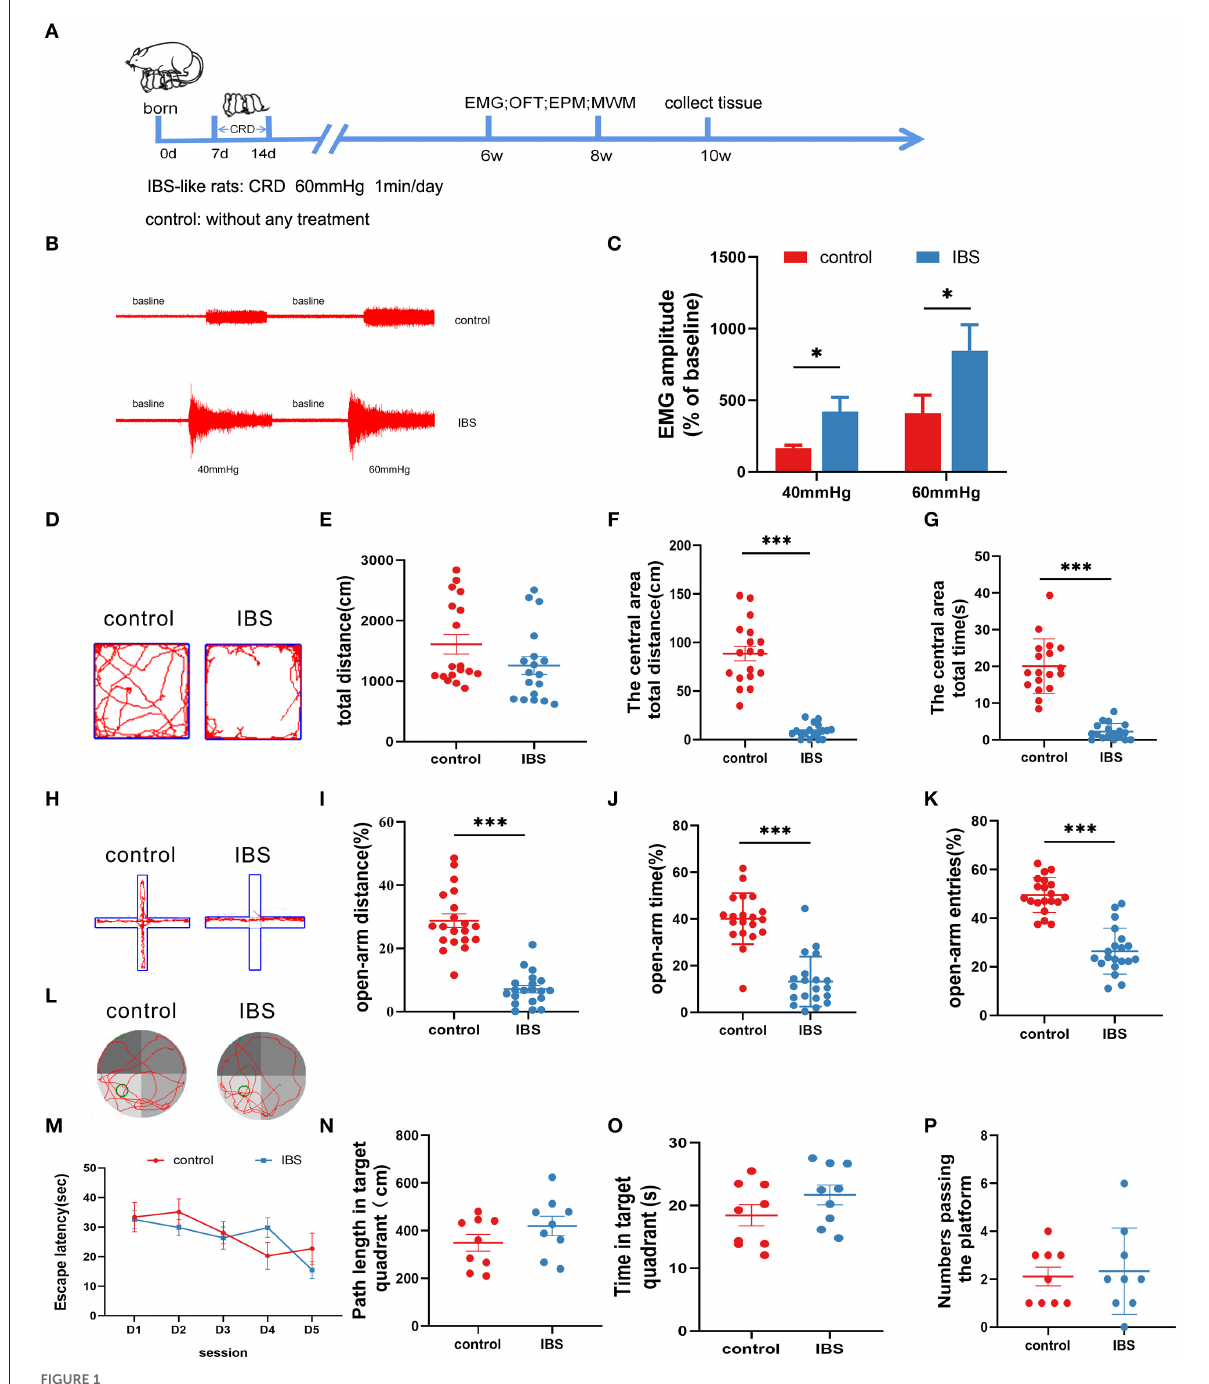
FIGURE1 Neonatal CRD induces visceral hypersensitivity and anxiety without cognitive impairment in IBS-like rats. (A) Experimental design. (B,C) The original graph and statistical chart of EMG amplitude in IBS-like and control rats. N = 6, * p < 0.05. (D) Original typical traces of OFT. Statistical analysis of the total distance (E) , the distance in the central area (F) , and the time in the central area (G) in the OFT. N = 18, *** p < 0.001. (H) Original typical EPM recordings. Statistical analysis of the distance (I) , the time (J) , and the number of entries (K) in the open arm of EPM. N = 20, *** p < 0.001. (L) The original typical recordings of MWM. The statistical chart of the escape latency (M) , path length in target quadrant (N) , time in target quadrant (O) , and numbers passing the platform (P) in MWM. N = 9. CRD, colorectal distension; EMG, electromyography; EPM, elevated plus maze test; IBS, irritable bowel syndrome; MWM, Morris water maze; OFT, open field